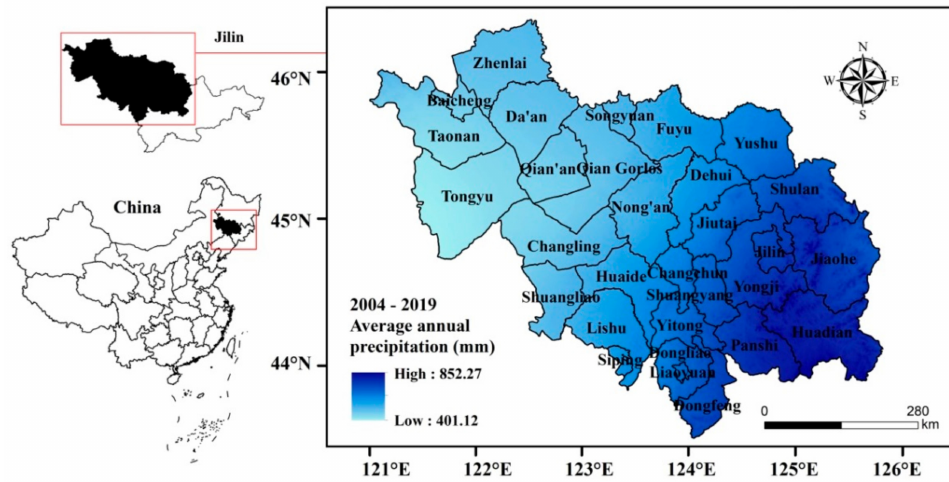
Figure 1. Location of the study area.